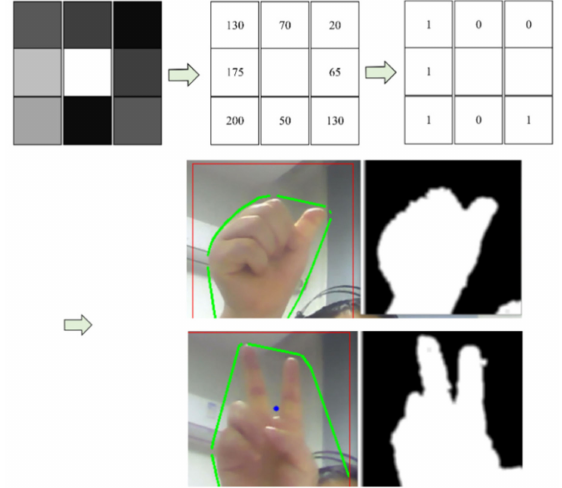
Figure 3. MCT process and results demonstration.